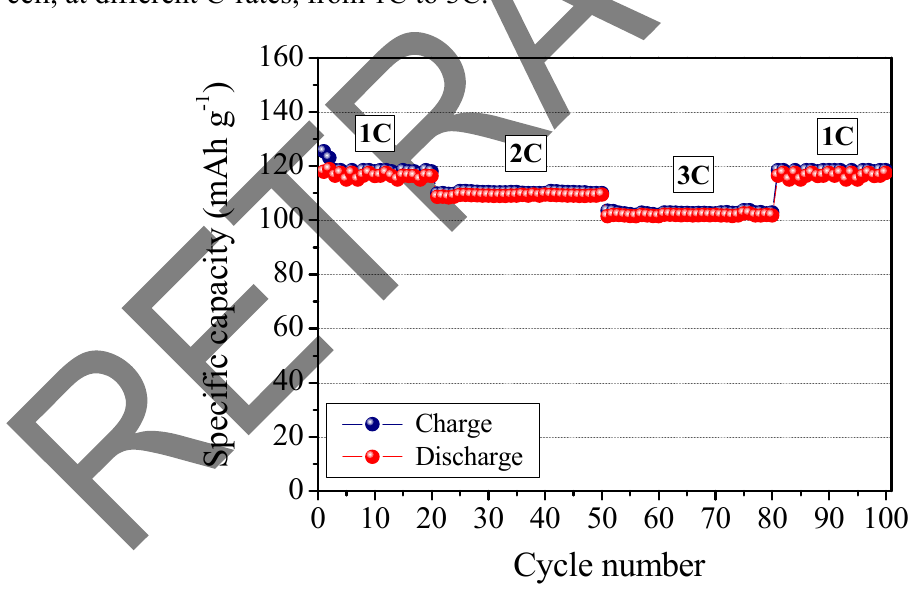
Figure 11. Ambient temperature cycling performance of a LiFePO cell, at different C-rates, from 1C to